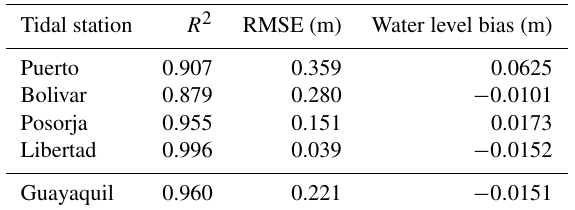
Table 3. Statistical evaluation of model performances for tidal lev- els at different stations.